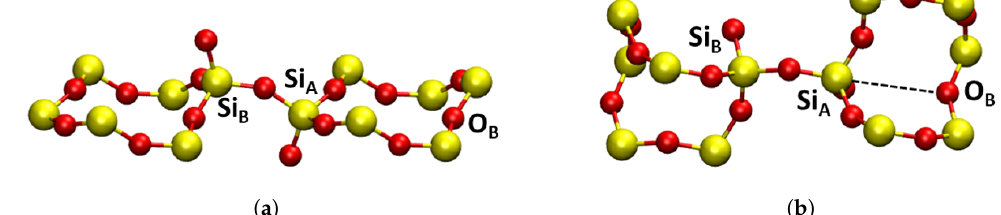
Figure 3. Local pristine structures of ( a ) α -cristobalite with two connected tetrahedrons and ( b ) α - quartz with two connected tetrahedrons with a ring containing back bonding O B . Yellow atoms are silicon and red atoms are oxygen. In α -quartz, Si A and Si B are not equivalent, but in α -cristobalite they are equivalent. The Si A and Si B notations are, therefore, used to distinguish the Si atoms in defects which are later introduced to the pristine structure. More detail is provided in the